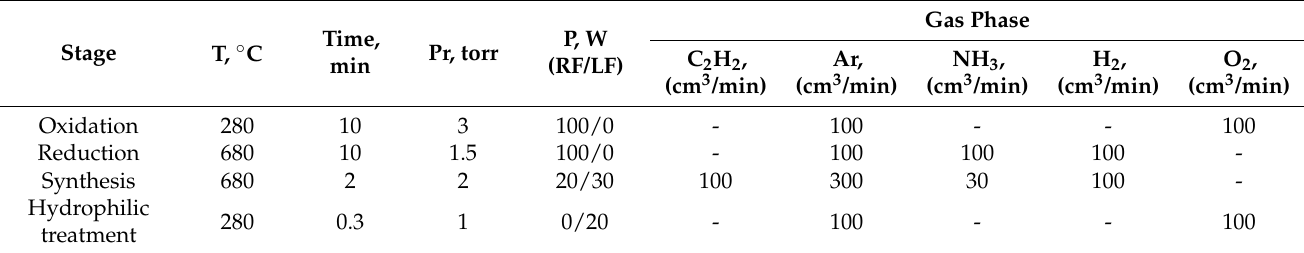
Table 1. The synthesis parameters of MWCNT